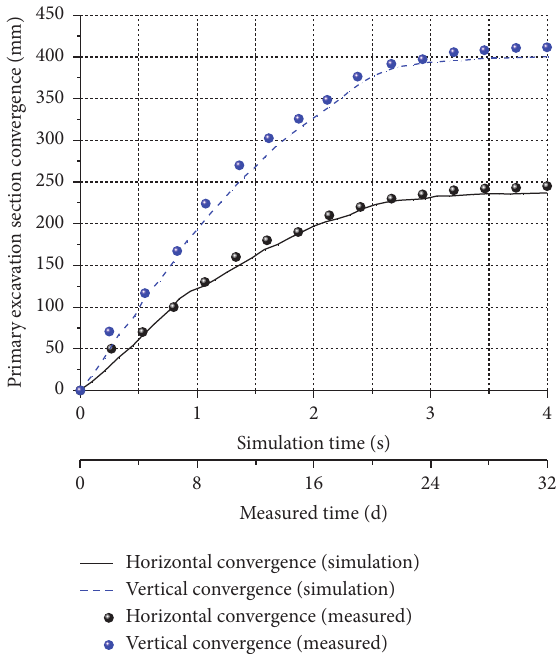
Figure 8: Comparison between the simulation and measured primary excavation section convergence in the Xin’an coal